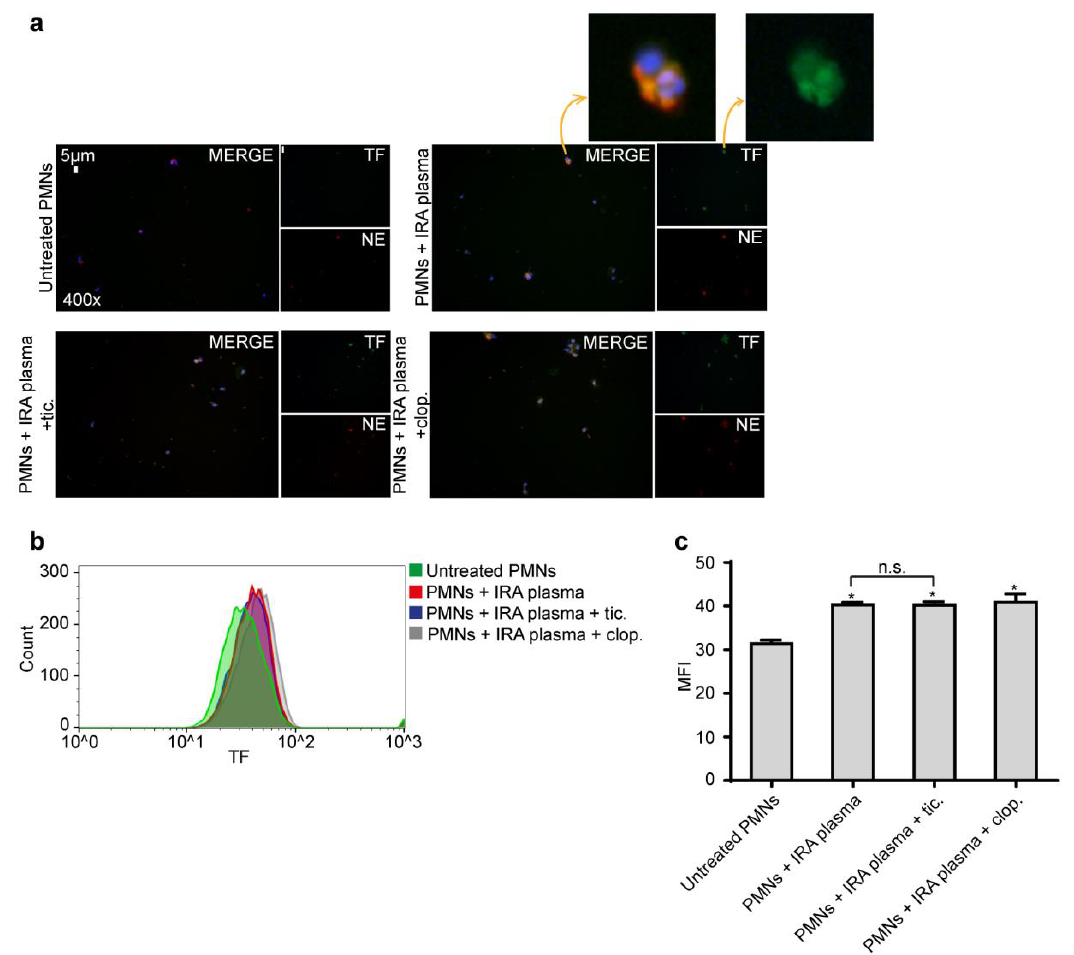
Figure 5. Ticagrelor is not able to inhibit intracellular expression of tissue factor (TF). ( a ). Fluorescence microscopy for TF / NE staining in control neutrophils treated with IRA plasma, with or without pre-treatment with Ticagrelor or Clopidogrel. One representative out of six independent experiments is shown. Original magnification: 400 × , Scale bar: 5 µ m. Blue: DAPI, Green: TF, Red: NE. ( b ). Representative fluorescence-activated cell-sorting analysis and ( c ) relative MFIs of TF in control neutrophils treated with IRA plasma, with or without pre-treatment with Ticagrelor or Clopidogrel. Data from six independent experiments presented as mean ± SD. Statistical significance * p < 0.05. n.s.: non-significant. All conditions were compared to the untreated / control condition and statistical significance is indicated by the symbol “*”. Any further non-statistical significance of other comparisons is indicated by the symbol “n.s.”. MFI—mean fluorescence intensity. ( a , b ) One representative out of six independent experiments is shown. Polymorphonuclear neutrophils